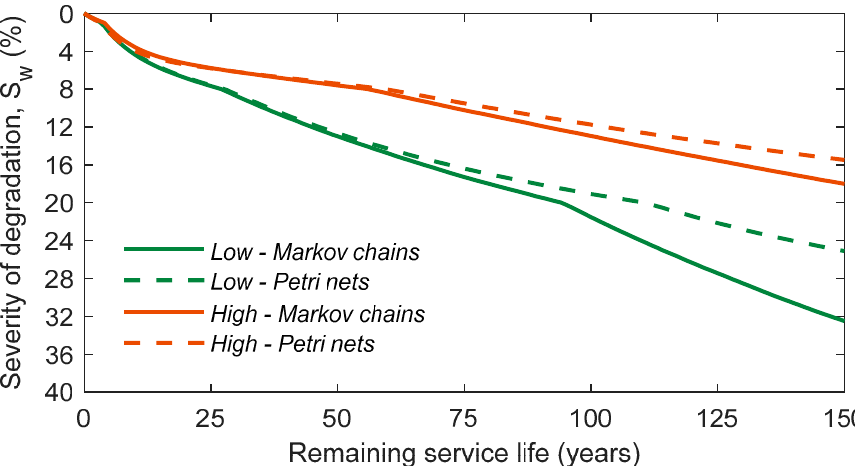
Figure 8. Comparison of the average degradation curves obtained for both models and heights.